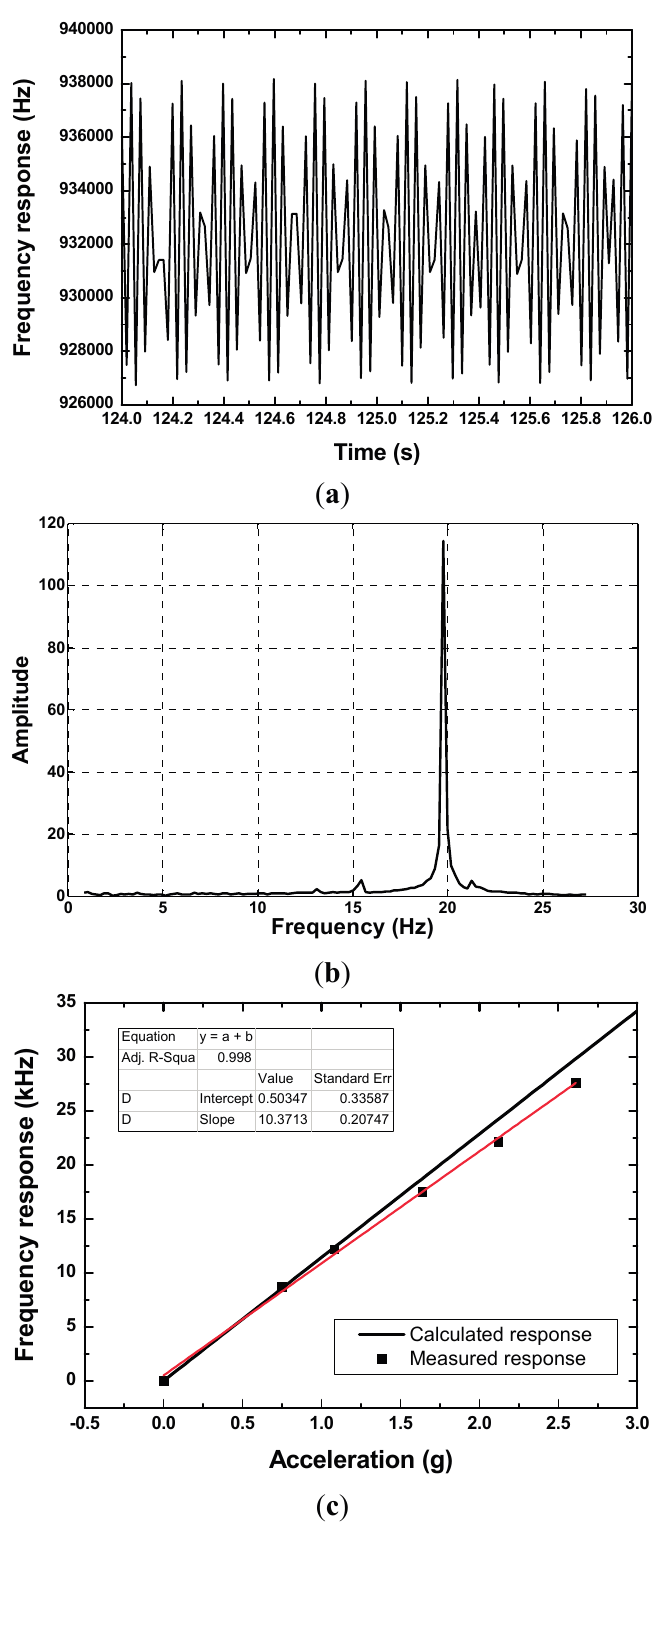
Figure 7. ( a ) Measured transient response; ( b ) spectrum; and ( c ) vibration sensitivity of the developed vibration sensor, and also in comparison to the calculated